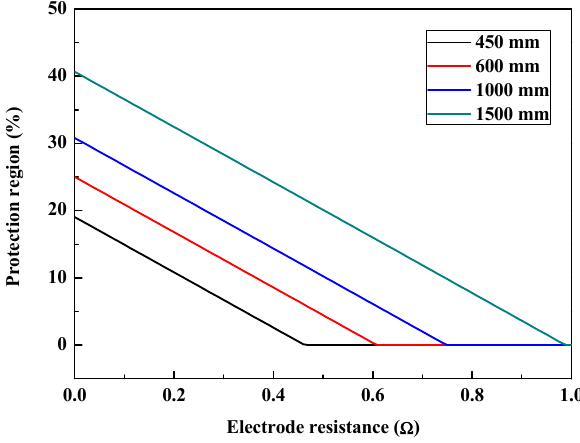
Figure 14. Influence of electrode resistance on protection region of arcing horns.